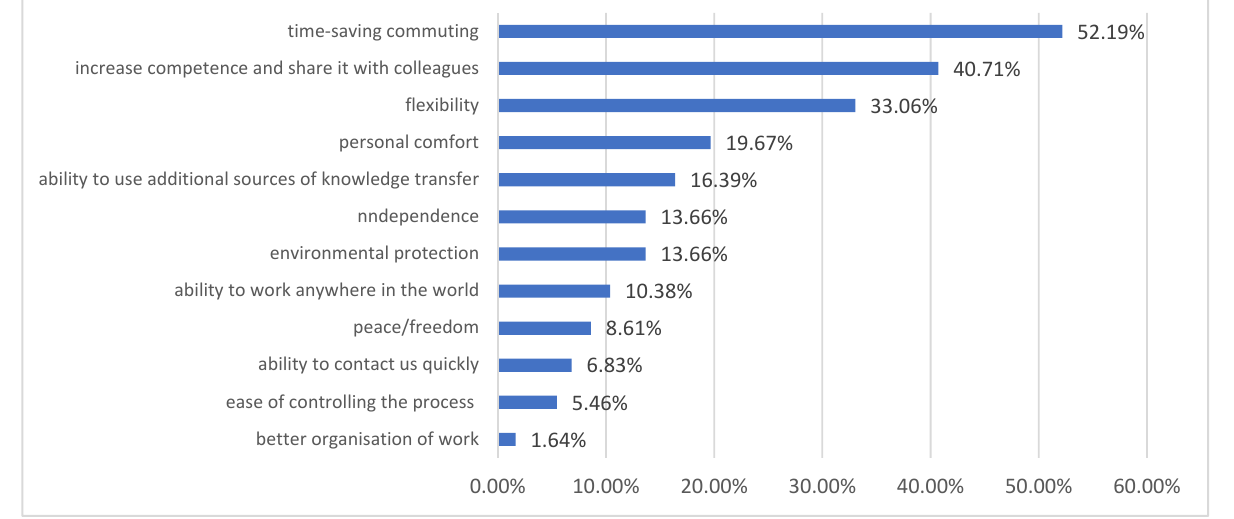
Figure 3. The advantages of remote work indicated by the respondents.